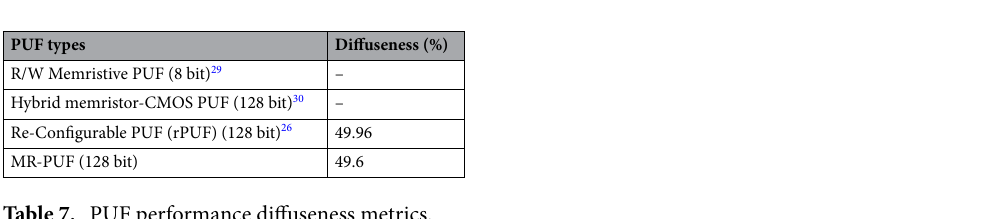
Table 7. PUF performance diffuseness metrics.